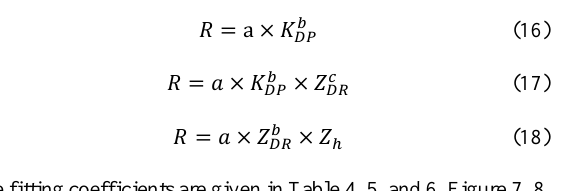
Figure 4. μ - Λ curve in different areas